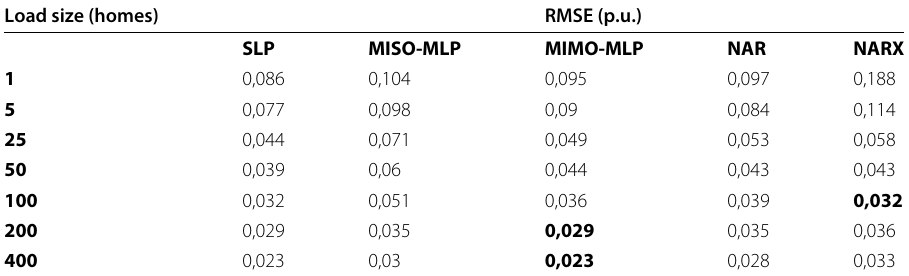
Table 3 Mean RMSE of 100 networks predicting loads of different size (number of homes in the aggregation). Confidence intervals are denoted in Fig. 4 Load size (homes) RMSE (p.u.)